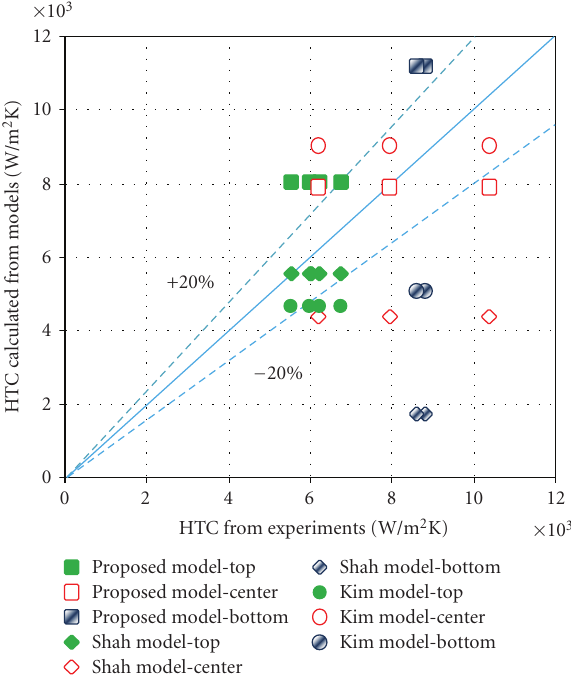
Figure 22: Benchmark evaluation of PERSEO data according to the various condensation